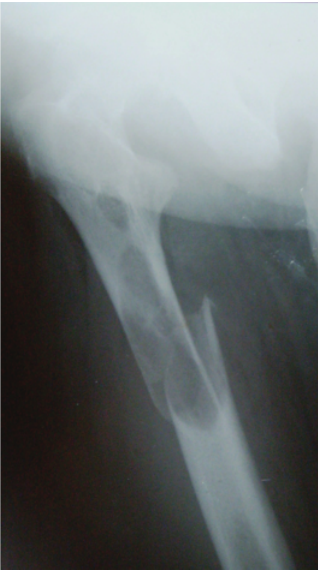
Figure 1: Radiographs of pathological subtrochanteric fracture of right femur.